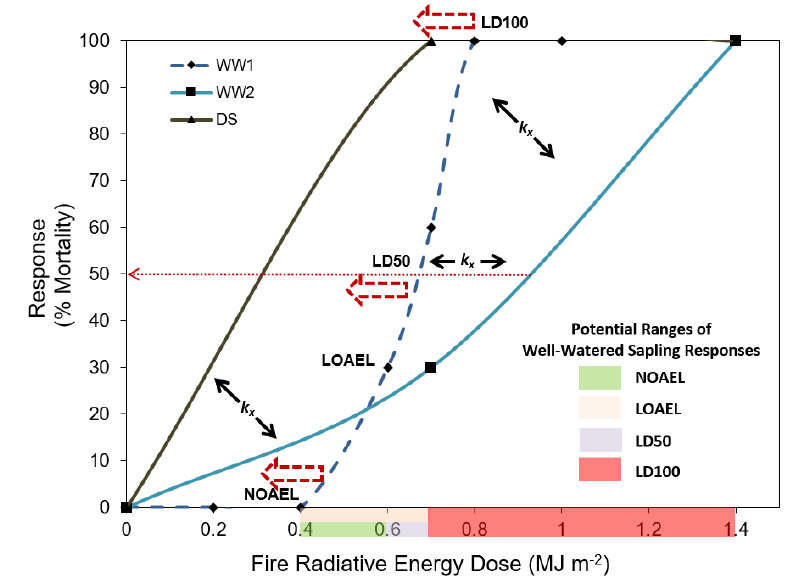
Figure 6. Comparison of Pinus ponderosa sapling mortality after exposure to surface fires with different fire intensities across several studies. WW1 represents data from well-watered saplings reported in [29]. WW2 and DS represent the well-watered and drought-stressed saplings in the current study. Adapted from [24]. LDY denotes the lethal dose to cause Y% mortality, NOEAL represents the no observed adverse effect level, and LOAEL represents the lowest observed adverse effect level. The k x refer to center point, slope, and scale coefficients used within the Regional Hydro-Ecological Simulation System model (RHESSys) [21].